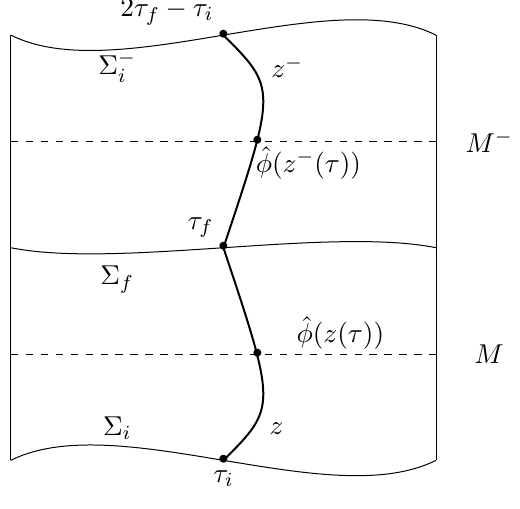
Figure 2 . Pasting of the integral in figure 1 (after removing the fermionic degrees of freedom) along Σ f